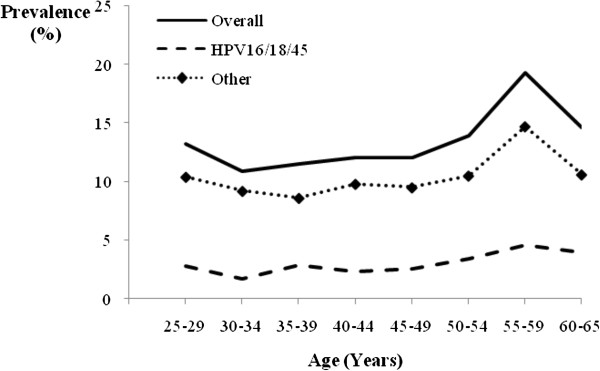
Age group-specific prevalence of any high-risk HPV, any HPV16, 18, and/or 45 (HPV16/18/45), and high-risk HPV other than HPV16/18/45 at baseline. Figure 2 Symbols: (bold line) Overall, (dash line) HPV16/18/45, (dot-dash line with solid diamond) Other.